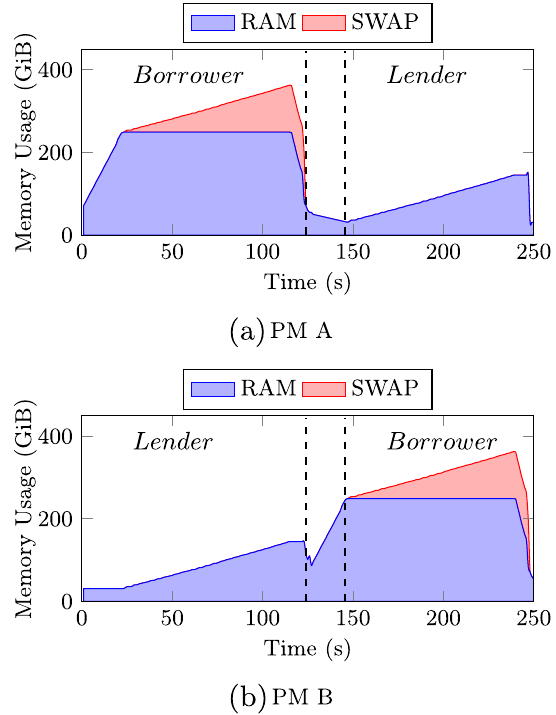
Fig. 10 Experimental results of memory usage over time. The experiments are conducted by running a mock application to overload memory resource of PM A and PM B sequentially. The memory shortfall (swap) on the PM with Borrower role is filled up by the same amount of RAM from the PM with Lender